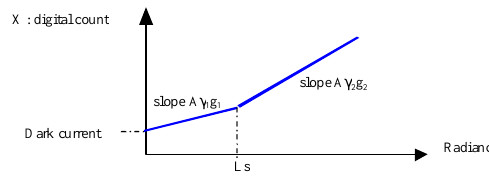
Figure 4. Bilinear radiometric model